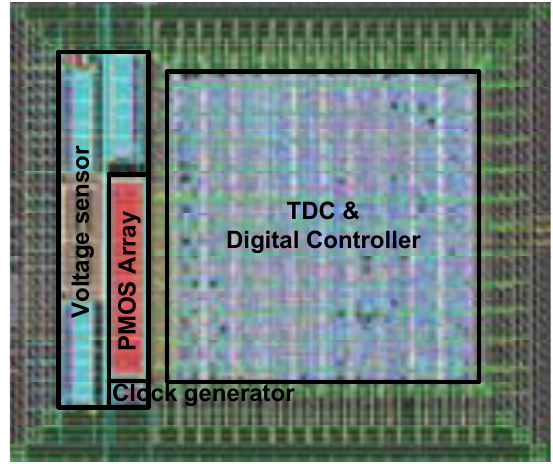
Figure 8. The layout of the proposed fast response DLDO.